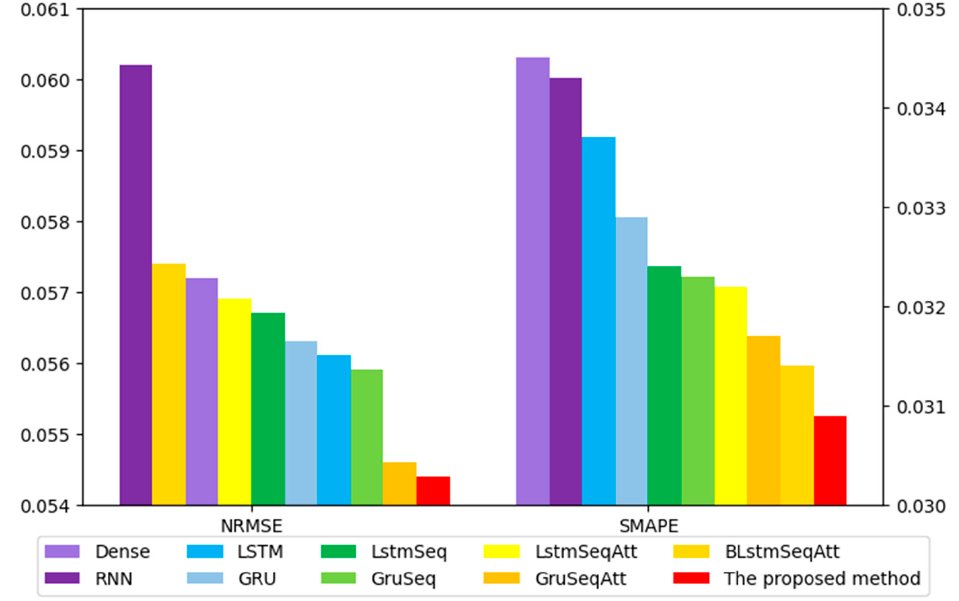
Figure 10. NRMSE and SMAPE of different models.